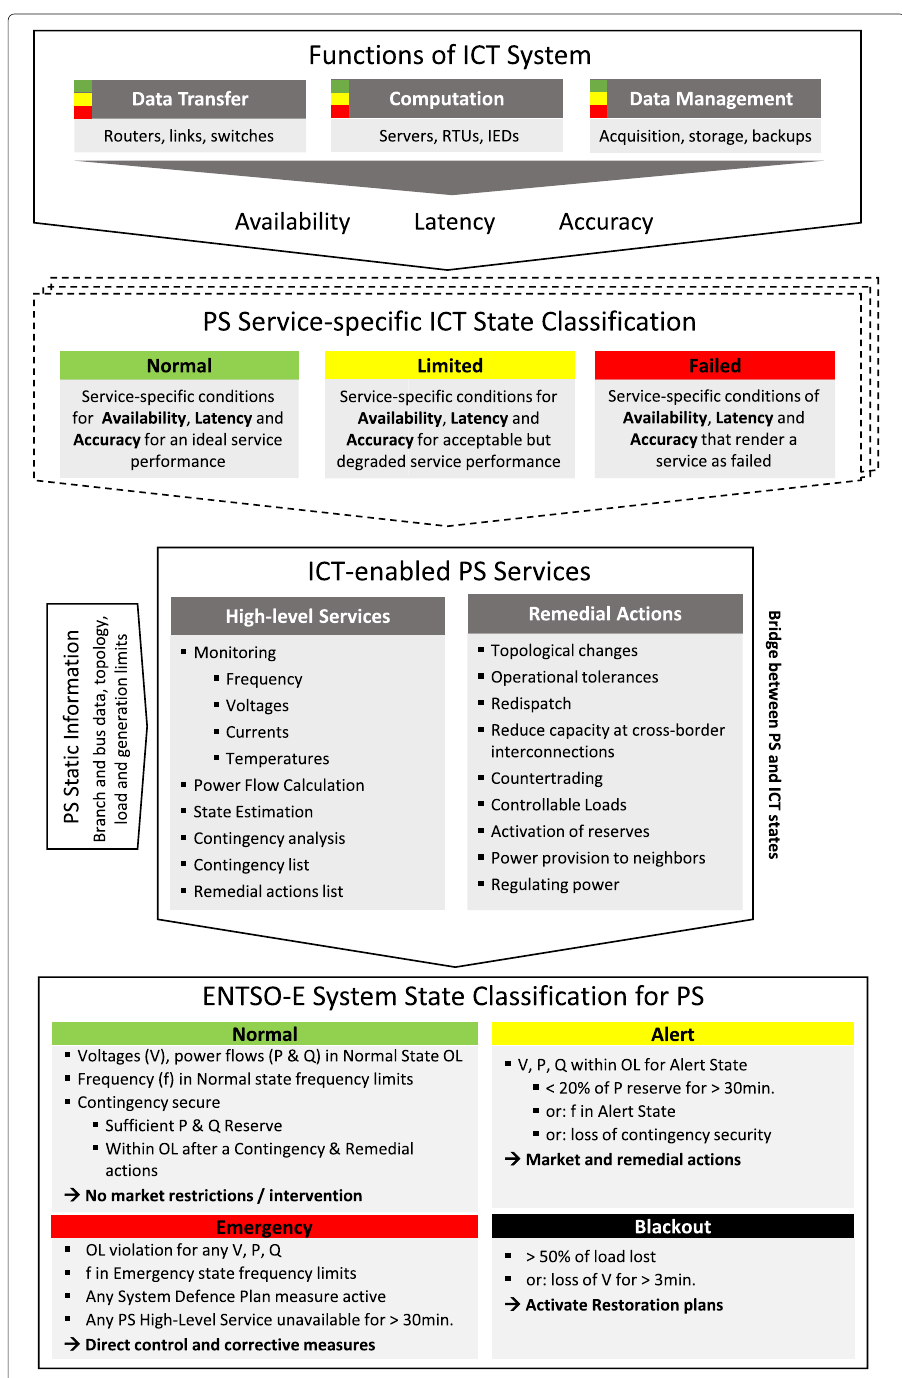
Fig. 3 Bridge between PS states and ICT States via ICT-enabled PS Services